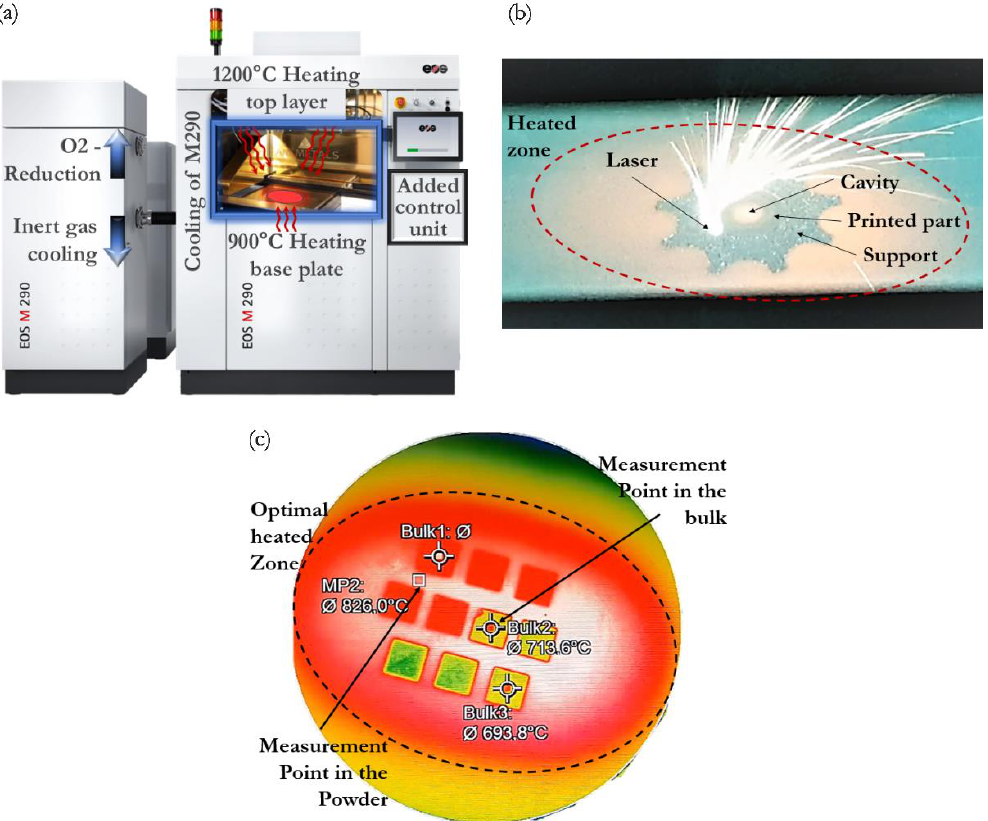
Figure 1. ( a ) EOS-M290-HT system with base plate heating up to 900 °C; the uppermost powder bed layer can be heated up to 1200 °C; cooling system of the machine using inert gas; gas purification system for O 2 -level <200 m. ppm; additional control unit, sensors, IR camera and data logging; for further details, see text; ( b ) heated zone in the process chamber of the EOS-M290-HT, the manufac- tured turbocharger turbine wheel has a diameter of ~40 mm; ( c ) analyzed IR camera data in the heated zone of the EOS-M290-HT. The squares have a side length of 10 mm.